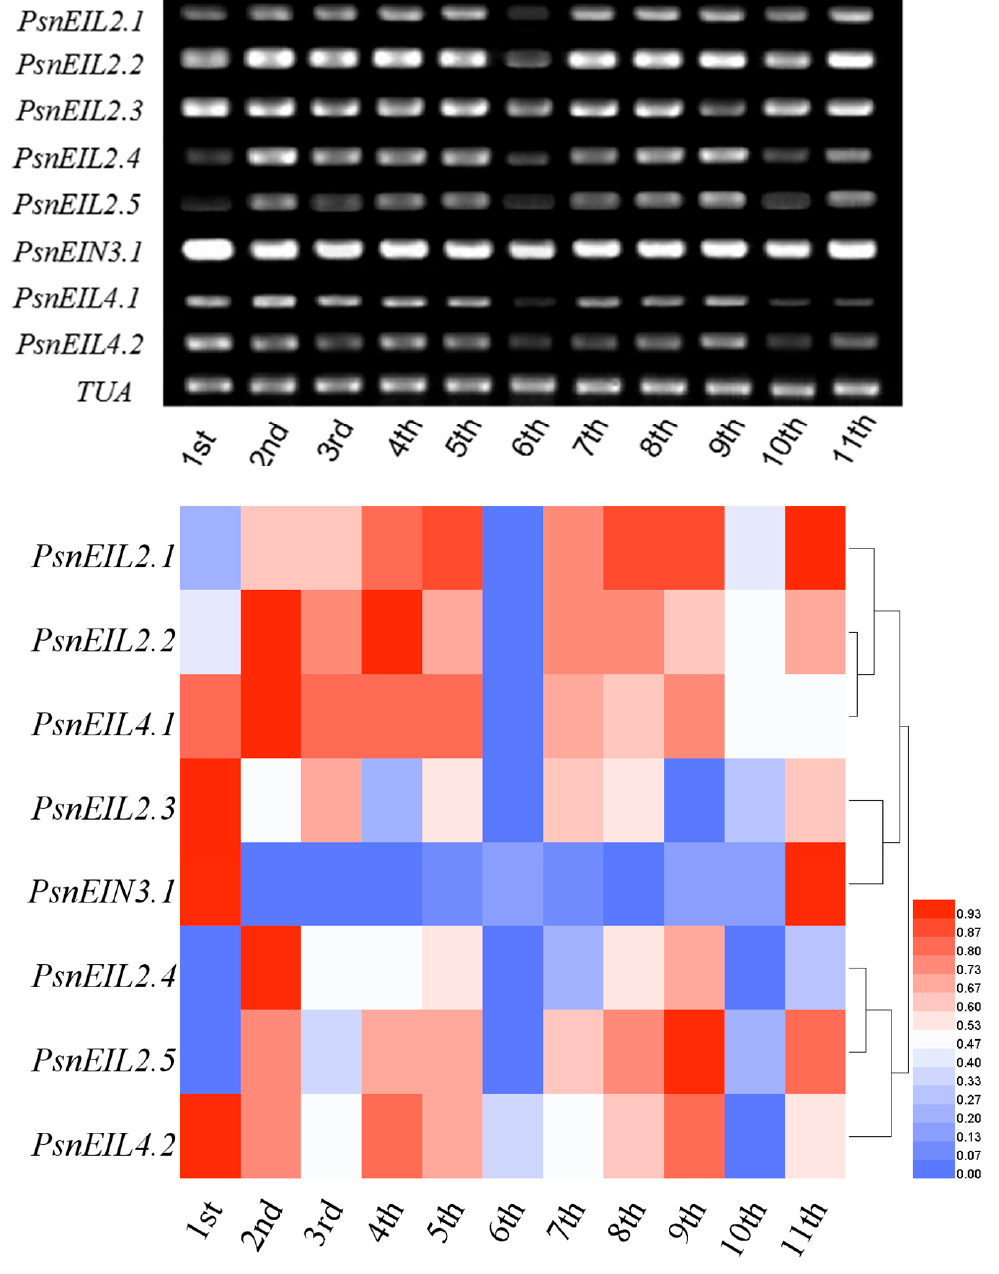
Figure 9. PsnEIN3/EIL gene expression patterns in different stem segments of Populus × xiaohei . Heat map showing the expression levels of the PsnEIN3/EIL genes in different stem segments. The first stem segment (1st) to the eleventh stem segment (11th) are presented in abbreviated form.